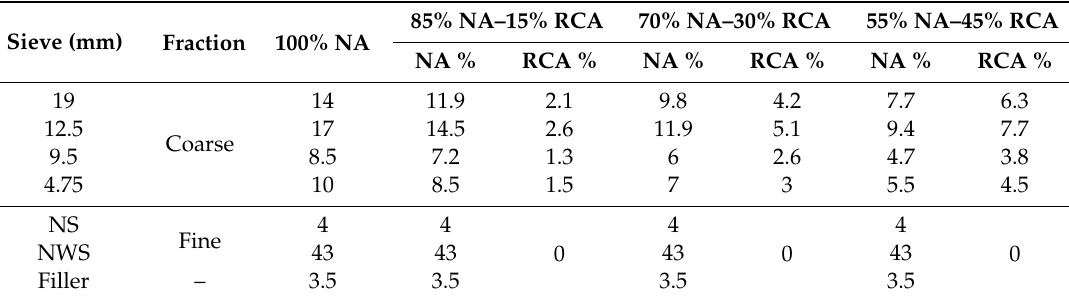
Figure 4. Crushed size distribution of the recycled concrete aggregate from a pavement.